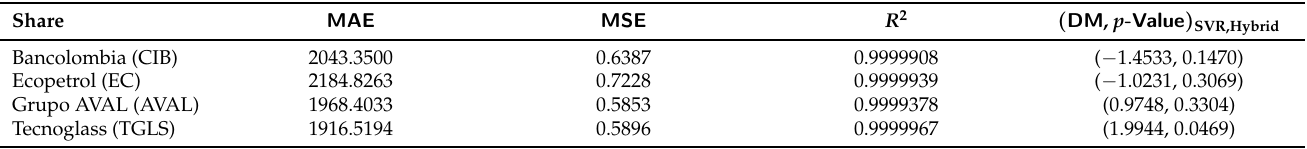
Table 6. MAE, MSE , and R 2 for the cumulative returns forecast using the SVR model. The Diebold– Mariano test was used for the prediction pair ( DM , p -value ) multiplied by 10 − 7 .